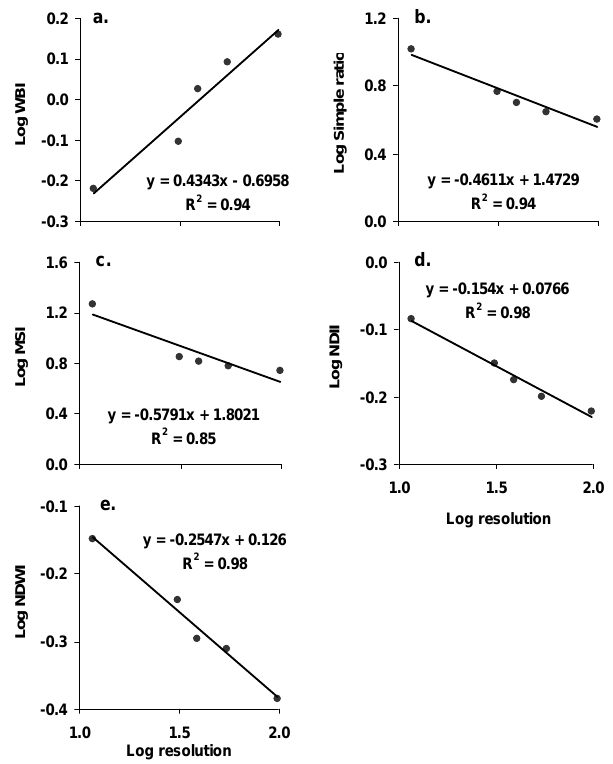
Fig. 6 – Up-scaling current spectral indices; the log of the spectral indices WBI (water band index), Simple ratio , MSI (moisture stress index), NDII (normalized difference infrared index), and NDWI (normalized difference water index) are plotted against the log of the spatial resolution, in site 106 on August 12 th , 2007 (n = 5, significance level < 0.05, and critical value R 2 > 0.65).